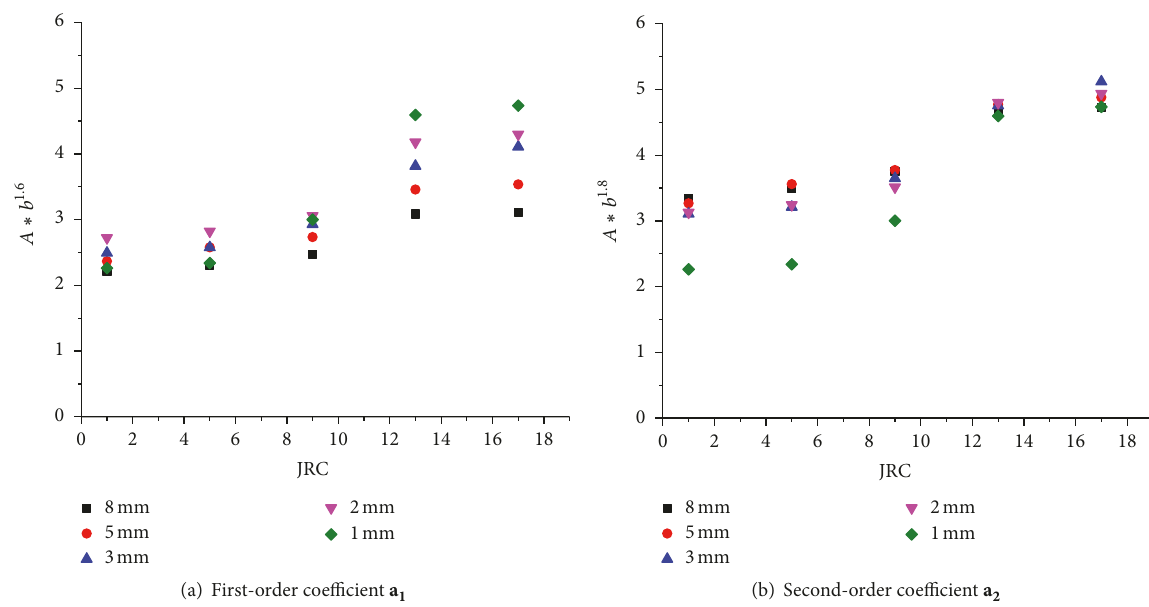
Figure 12: Relation between coefficient a of Forchheimer equation and JRC.